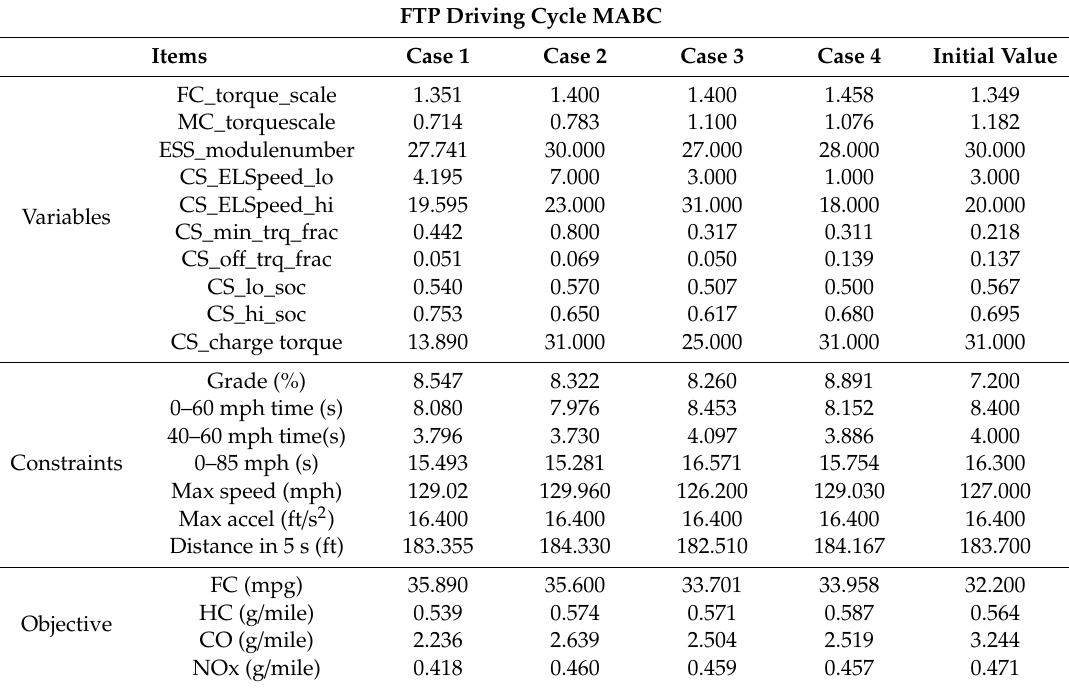
Table 3. Optimization results for the FTP driving cycle.